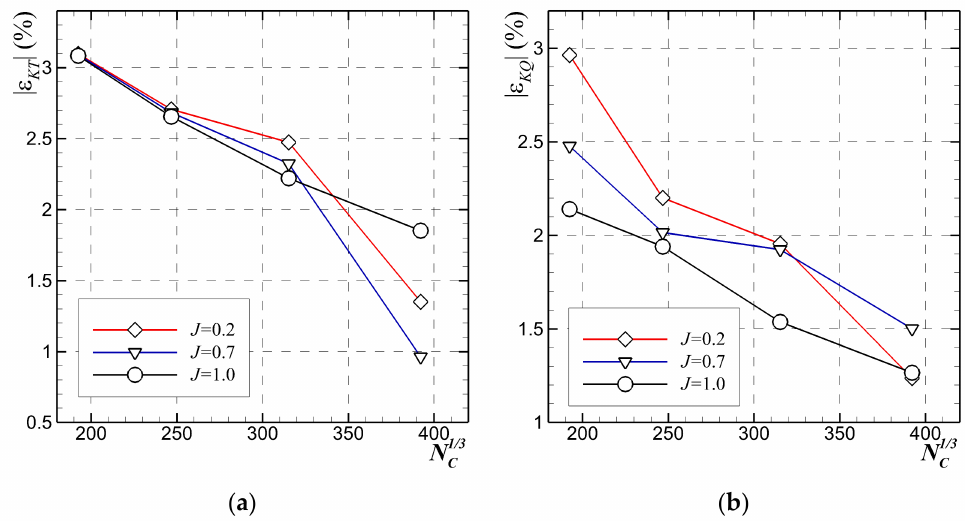
Figure 2. Errors in grid convergence test performed for the POW computation. ( a ) K T , and ( b ) K Q . The grid refinement ratio r Gi = ( N C ( G 4 ) / N C ( G i )) 1/3 , its number of cells N C , and (cid:0)